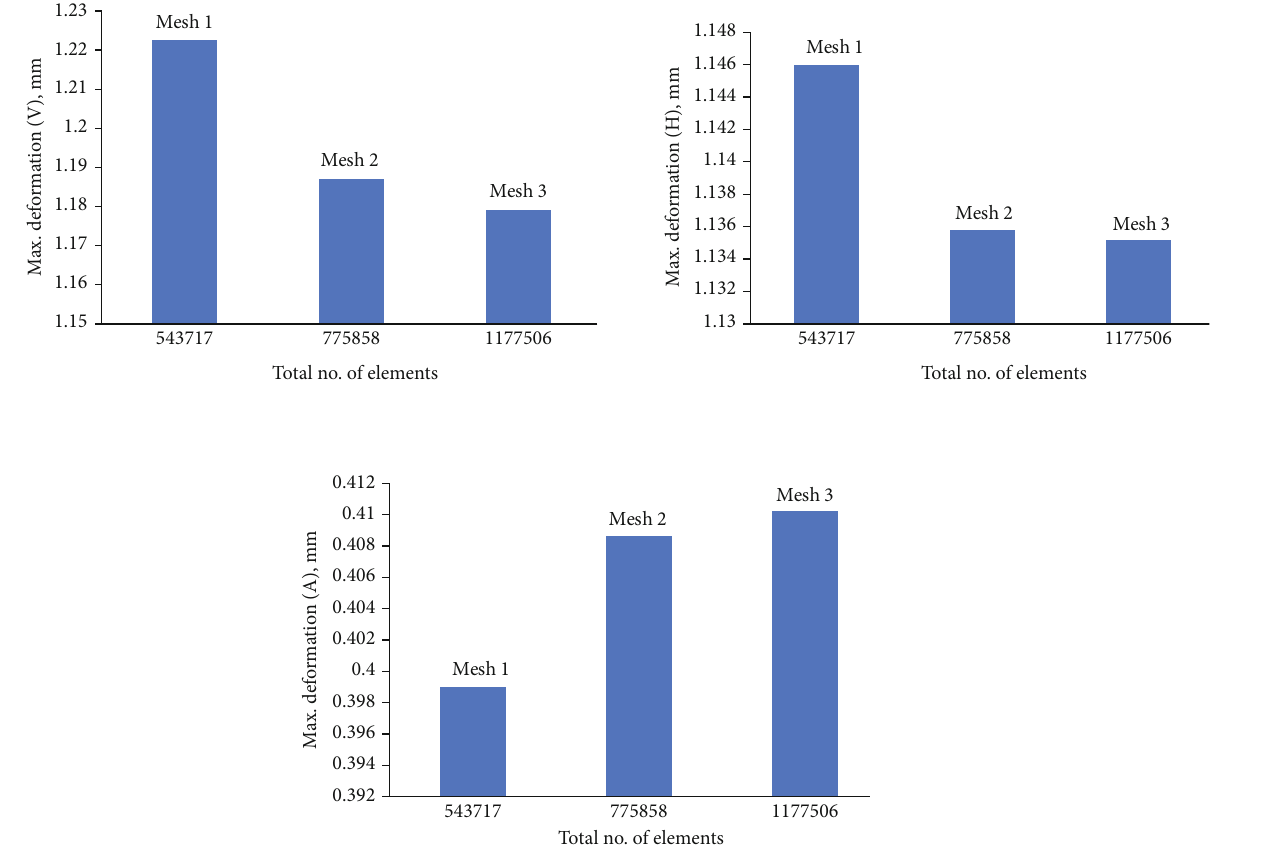
Figure 4: Mesh independence study plots of FEA model.